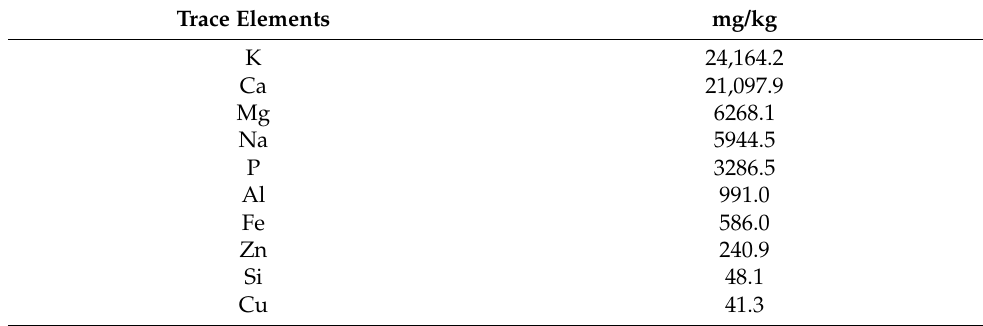
Table 3. Trace element analysis of chicken